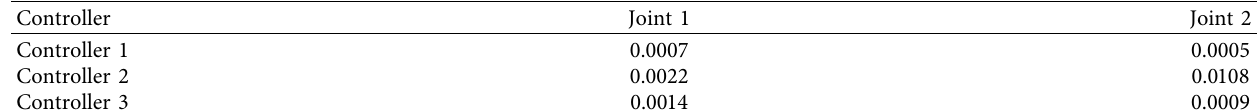
Table 2: Comparison of RMSE (rad) of 3 controllers (3s).